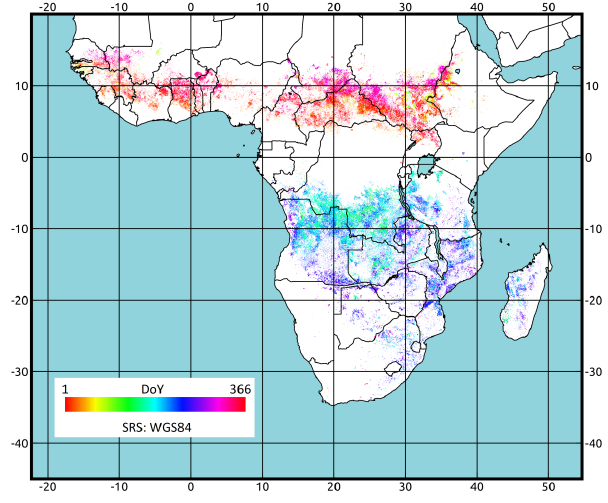
Figure 2. Day of the year (DoY) when the pixels are detected as burned in tropical Africa (2008).